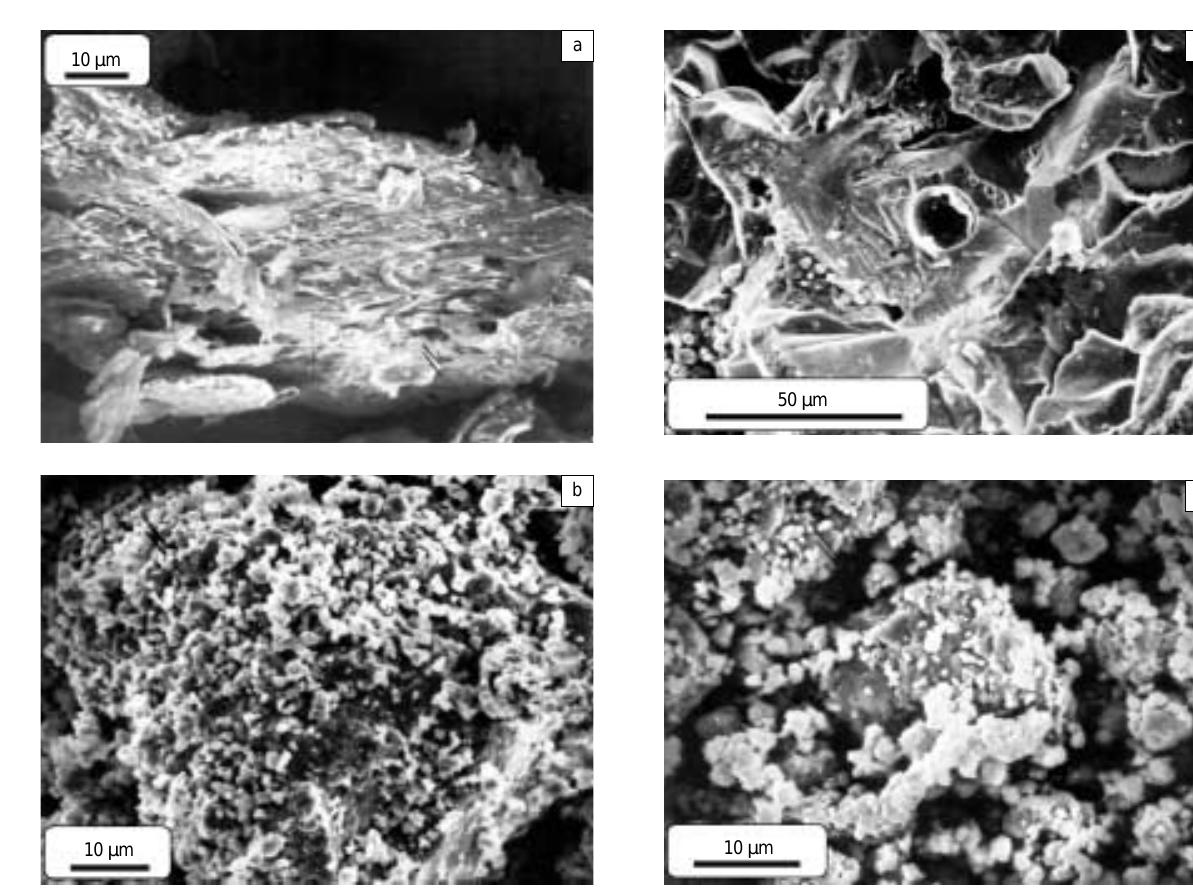
Fig. 2 Microphotograph of a cross section cleavage of the lay- ered composite of the system of Ni 32 wt.% Al after mechanical activation for 30 s (a), 25 min.